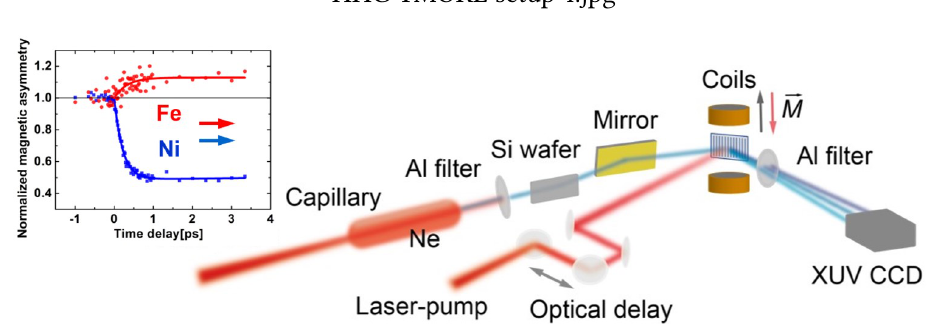
Figure 8: Experimental setup for element-selective spin dynamics. The laser pump and XUV probe beams are derived from a single laser amplifier. The XUV light propagates in vacuum and contains a spectrum of photons with energies between 20 and 72 eV. The inset (left) shows time-resolved magneti- zation of the Fe and Ni layers in the Fe/Ru/Ni trilayer. The magnetic asymmetry at the Fe 3p absorption edge anomalously increases for the parallel magnetic orientation of Ni and Fe layers thus confirming the presence of laser-driven spin superdiffusion from Ni to Fe